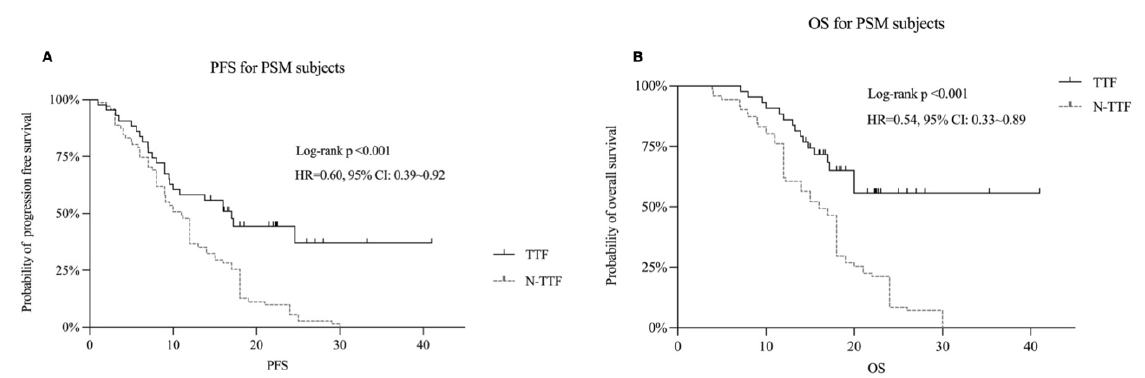
Figure 2. Kaplan–Meier survival analysis after propensity score-matching (PSM) in comparing TTF versus Non-TTF group; progression-free survival (PFS) is shown in ( A ) and overall survival in ( B ). MGMT methylation status impacted the outcomes between the two groups, with elevated risk of non-methylation group (HR = 1.13; 95% CI, 0.39–0.92; p < 0.001 and HR = 0.54; 95% CI, 0.33–0.89; p < 0.001, in PFS and OS, respectively). After inverse probability treatment weighting (IPTW), the baseline features of the two groups were balanced, and the significance remained (Table 5). Table 5. PFS and OS analysis after inverse probability treatment weighting (IPTW). PFS HR Std.